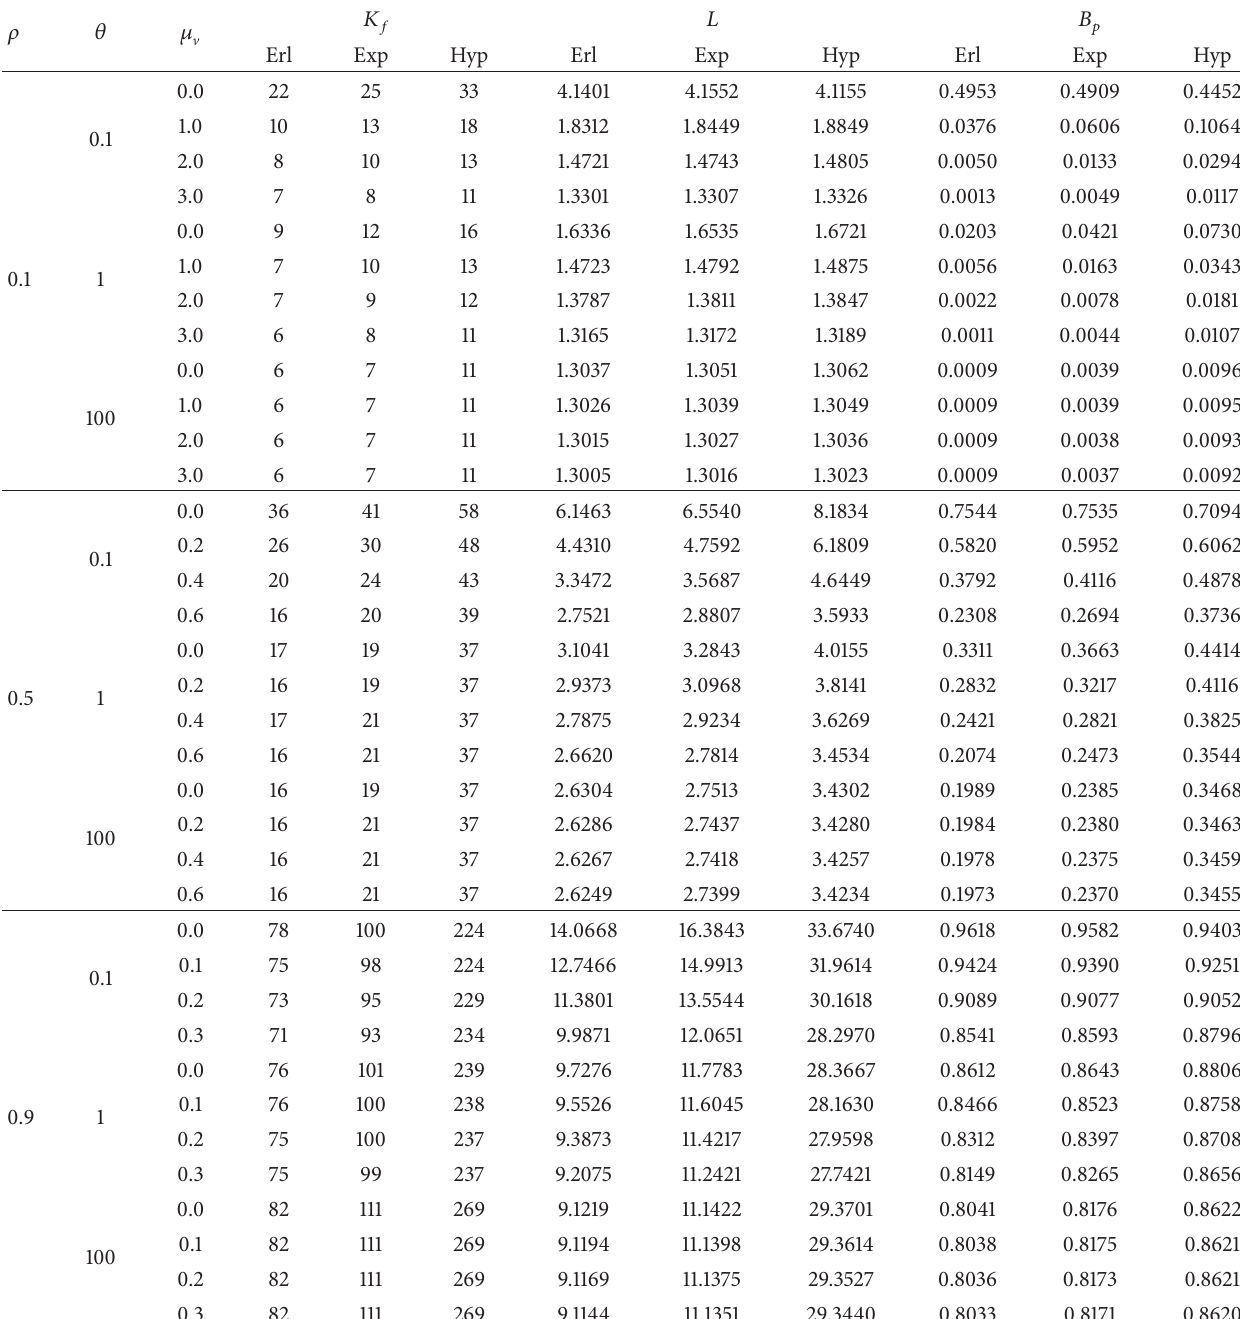
Table 2: Multiserver model with 𝑐 = 3